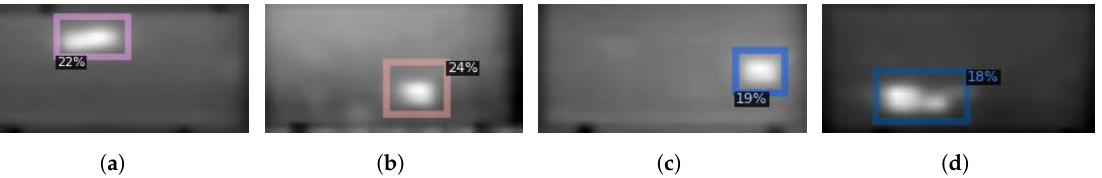
Figure 10. Four different hotspots ( a – d ) detected using our region-based CNN algorithm on the dataset acquired at Serramanna, Italy.